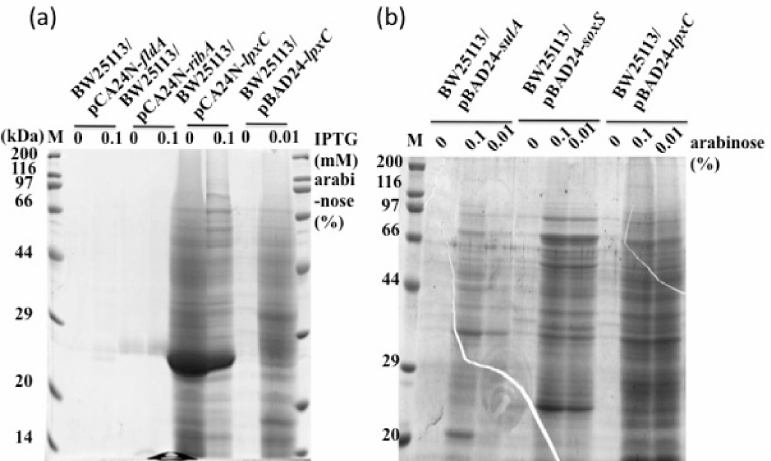
Figure 4. Effects of overexpression of selected SoxS regulon genes on SDCL. BW25113 cells harboring pCA24N- fldA , pCA24N- ribA , pCA24N- lpxC or pBAD- lpxC ( a ) and BW25113, BW25113 cells harboring pBAD-s ulA , pBAD- soxS , or pBAD- lpxC ( b ) were grown in LB medium containing ampicillin. L- Arabinose and IPTG were added at OD 600 of about 0.5 at the final concentrations of 0.1% or 0.01% and 0.1 mM, respectively. Portions of cultures were taken at 24 h after induction. Sample preparation for SDS-PAGE was performed as described in the Materials and Methods